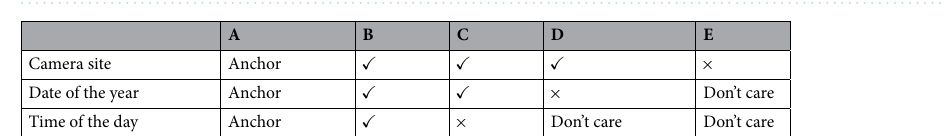
Figure 5. Graphical representations of the Self-supervised pre-training (left) and the Semi-supervised fine- tuning (right).